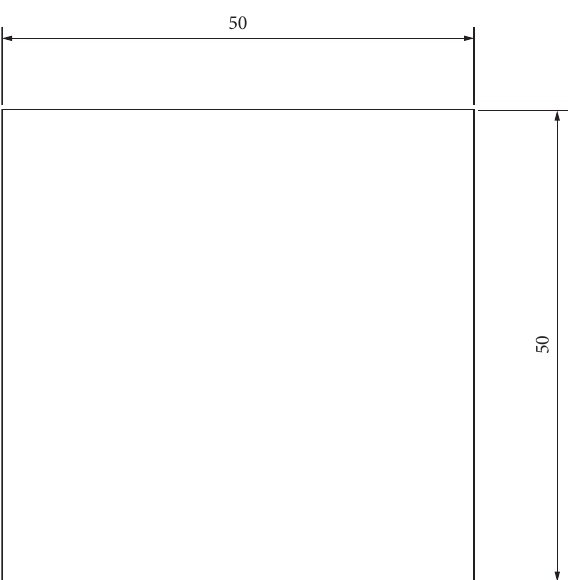
Figure 2: Test sample of surface performance. Table 4: Test average of TPE material